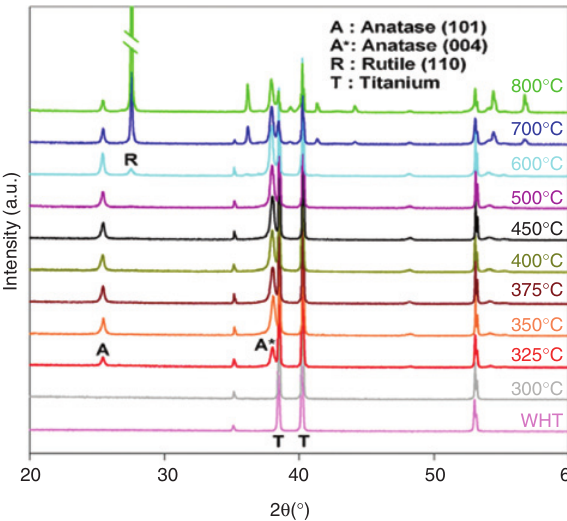
NTAs without heat treatment (WHT) 2